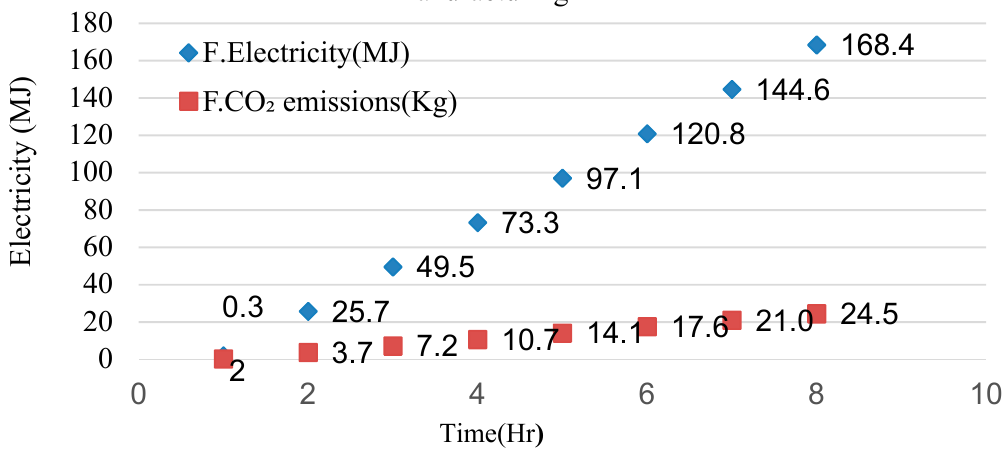
Figure 6. SimaPro 8 LCA simulation for the production of Flax/PLA tape.